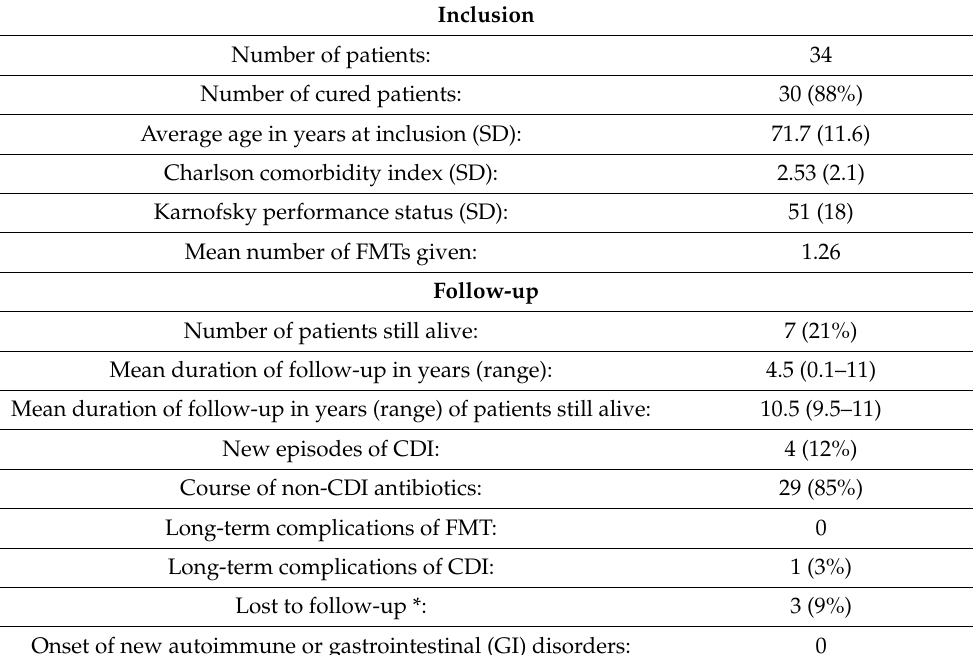
Table 1. Long-term follow-up of FMT recipients from the FECAL trial.